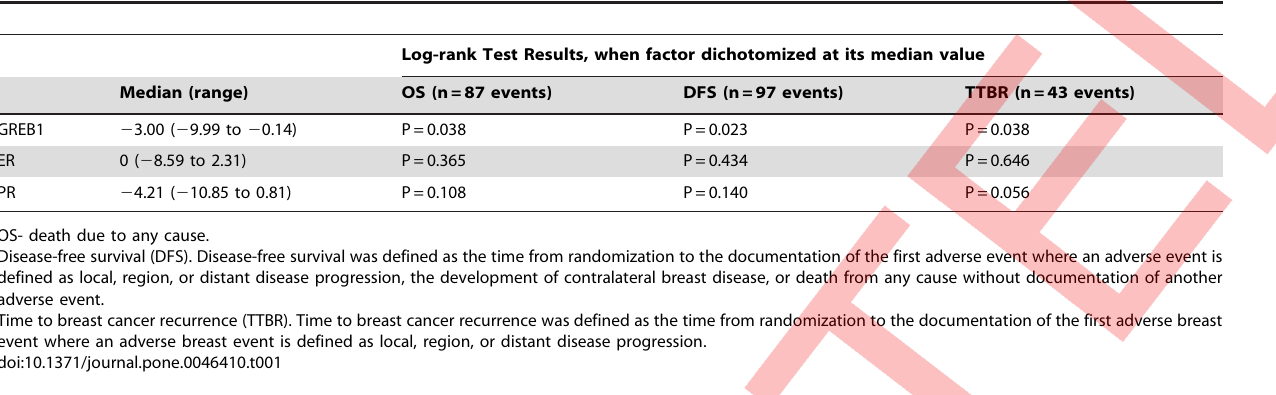
Table 1. 225 patients from the TAM arm of 89-30-52.